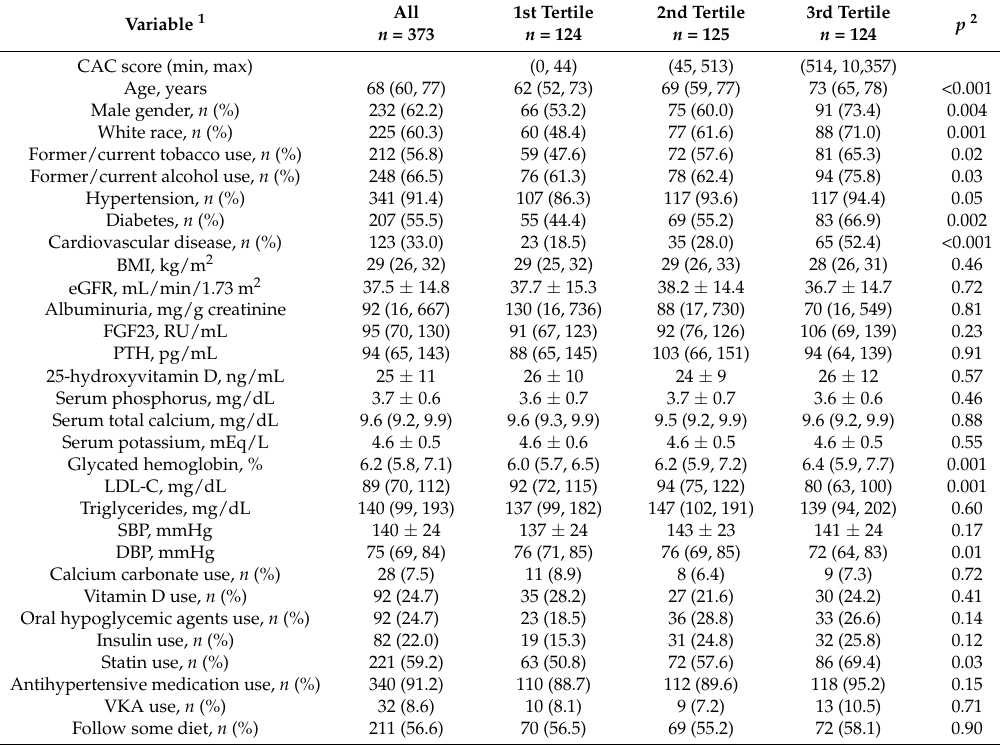
Table 1. Baseline characteristics of participants included in the study and according to tertiles of CAC. Variable